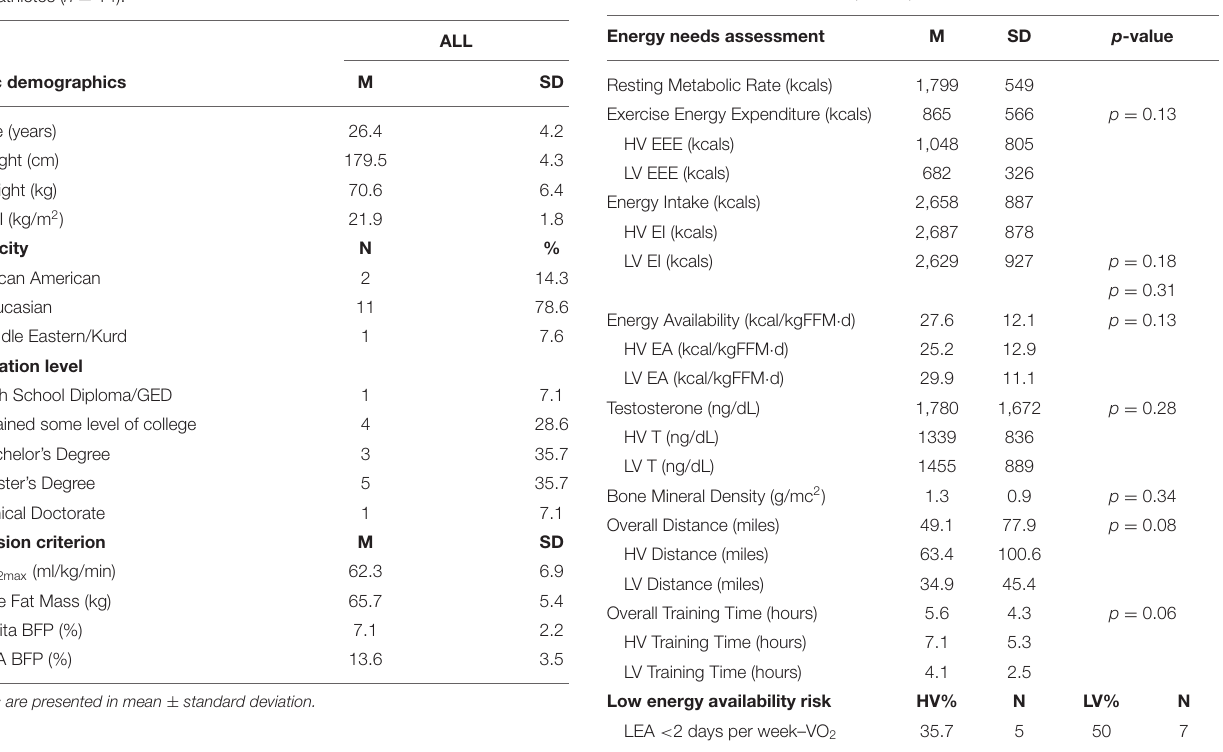
TABLE 1 | Basic demographics and an inclusion criterion for endurance trained male athletes ( n = 14).